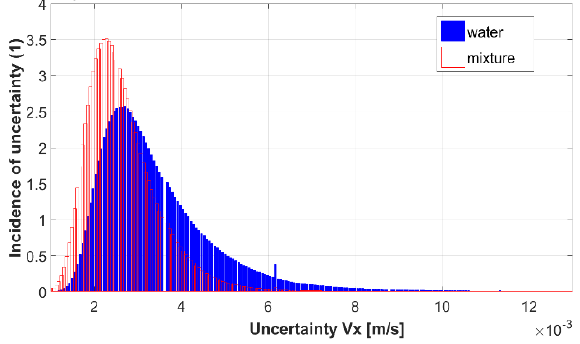
Fig. 5. Histogram of the x-velocity uncertainties. The blue columns represent the uncertainty distribution for water. Red columns represent the uncertainty distribution for index matching fluid.